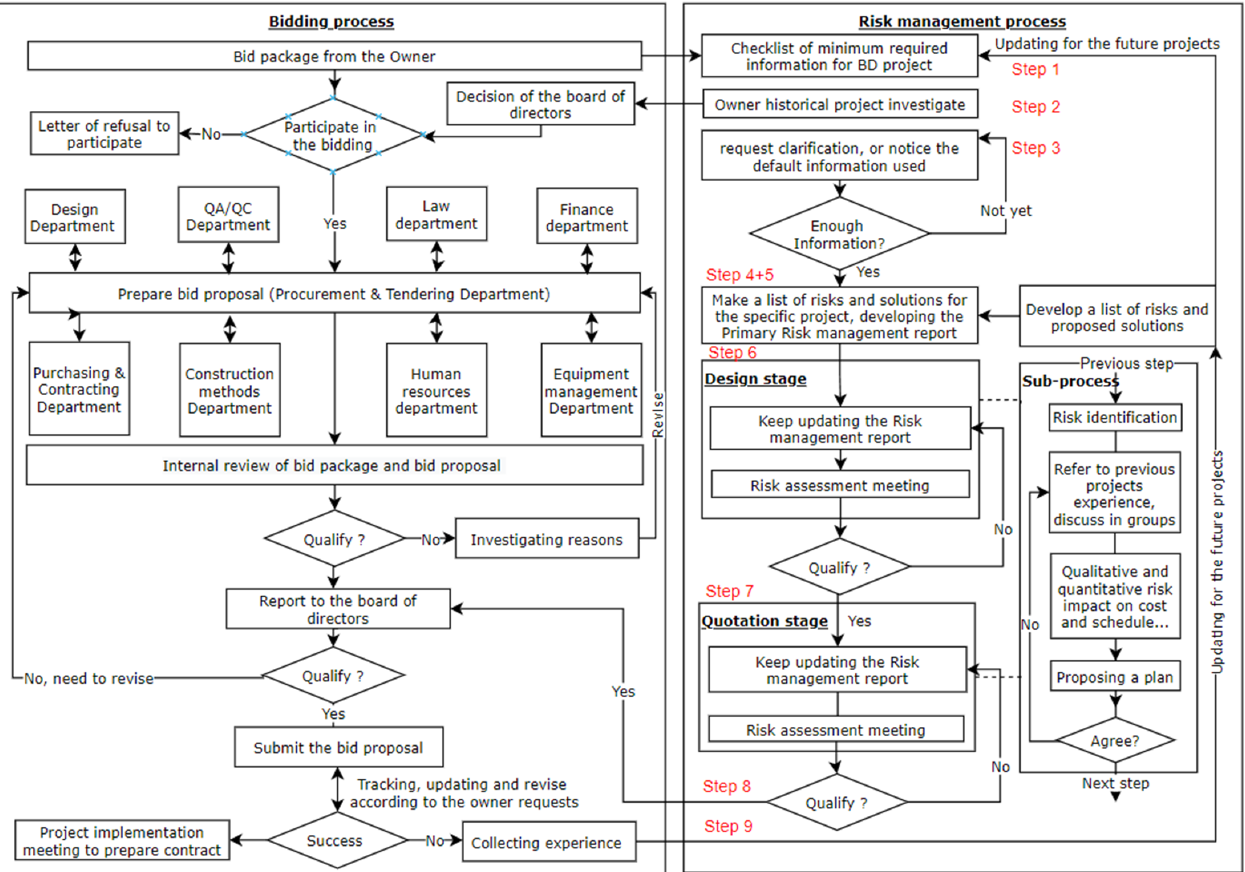
Figure 3. The risk management workflow for bidding stage.